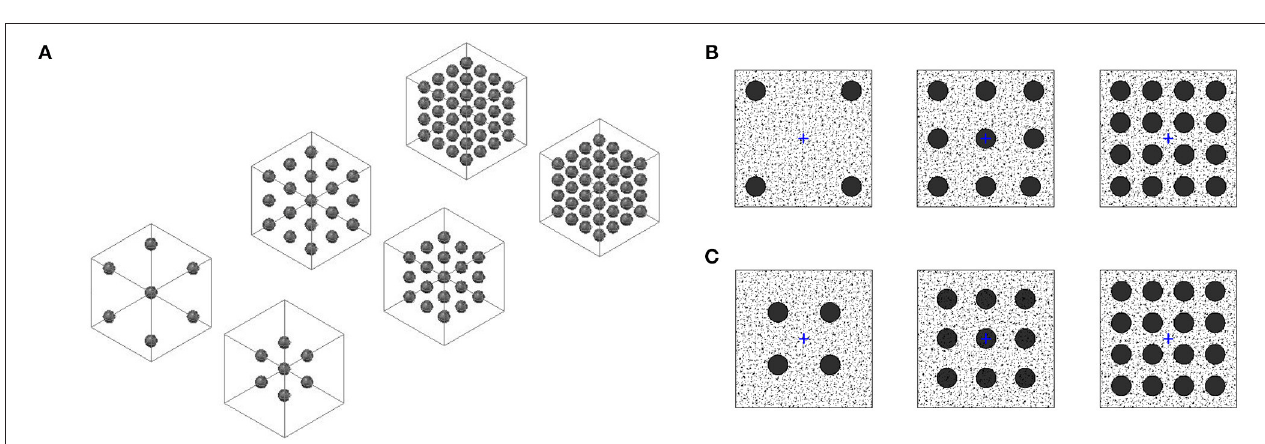
FIGURE 1 | Specimens used in the experiments. (A) S0: specimen without inclusions. (B) S8C-S8V: specimens with 8 inclusions (constant and variable cement cover and interspacing, respectively). (C) S27C-S27V: specimens with 27 inclusions (constant and variable cement cover and interspacing respectively). (D) S64C-S64V: specimens with 64 inclusions (constant and variable cement cover and interspacing respectively).